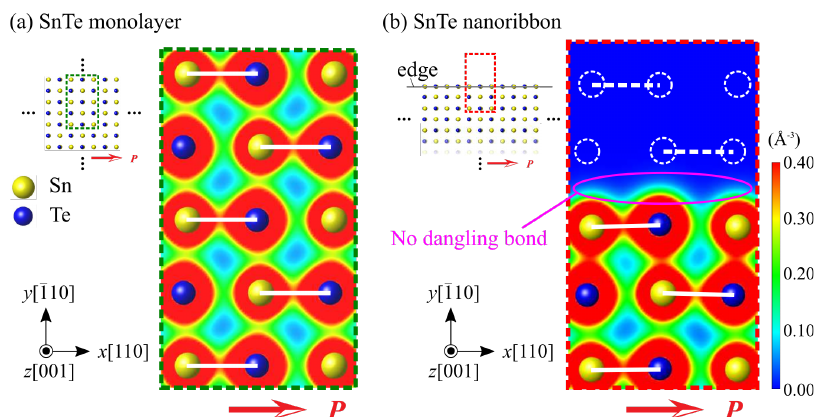
Figure 6. Charge density distributions ( a ) in the SnTe monolayer and ( b ) in the SnTe nanoribbon with 6-unit-cells width. Red arrows P indicate the spontaneous polarization. The covalent Sn-Te bonds are shown by white lines. White dotted circles and lines indicate the imaginary Sn or Te atom positions and Sn-Te bonds formed in the SnTe monolayer.